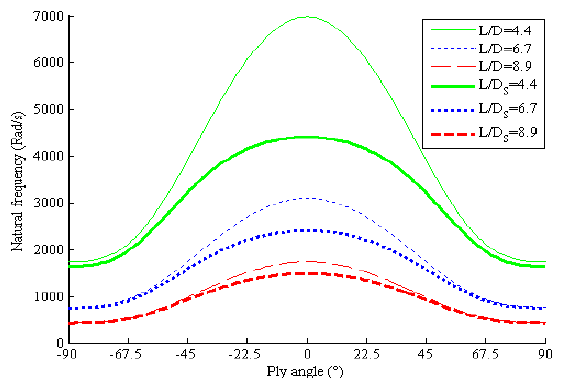
Figure 4. Comparison of natural frequencies for different L/D ratios.